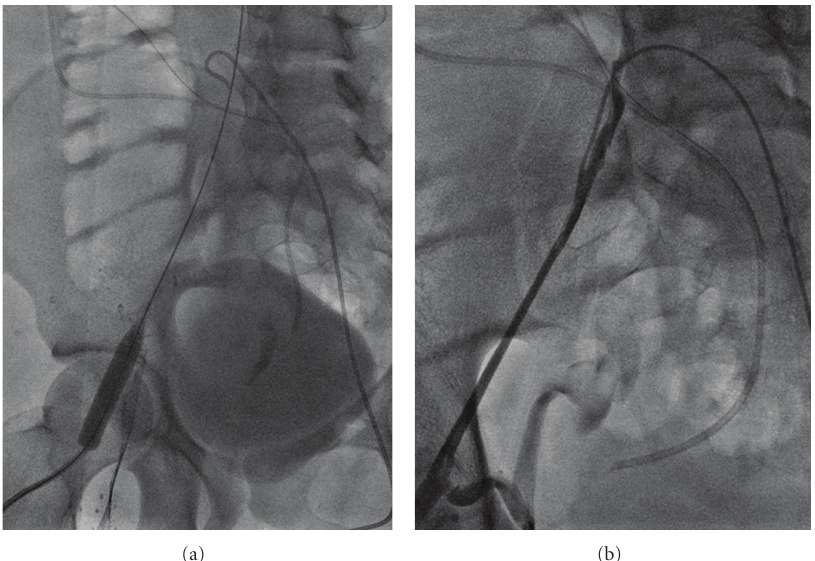
Figure 4: Balloon angioplasty of right iliofemoral system (a); follow-up venogram showing minimal improvement in diameter and flow via internal pelvic collaterals.